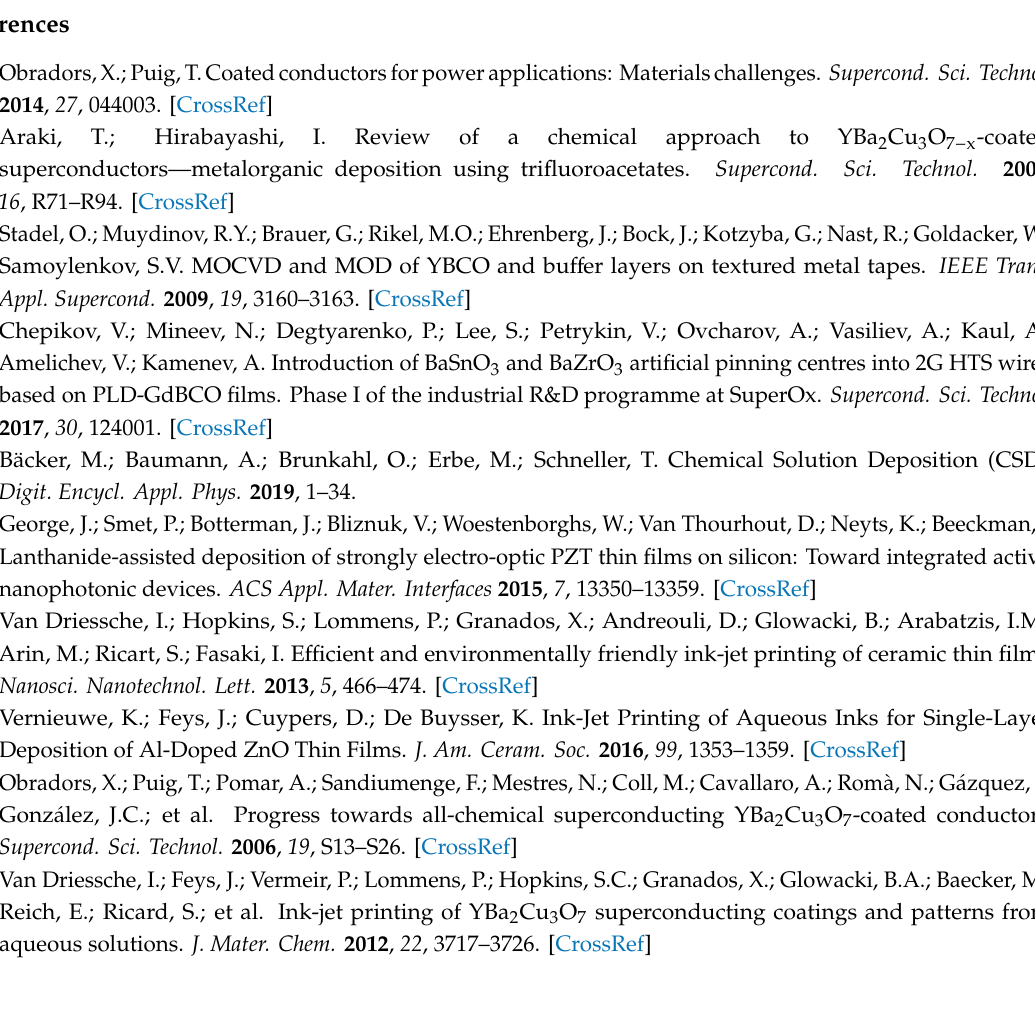
Figure S1. XRD patterns showing only reflections of the monoclinic phase after the heating-up synthesis of HfO 2 nanocrystals. Figure S2. Optimized jetting and non-jetting waveforms used for printing (A) pristine and (B) HfO 2 -YBCO inks. Figure S3. Cross-sectional SEM image of one single deposition of YBCO (A) without and (B) with 5 mol% HfO 2 nanocrystals after full thermal process. Figure S4. (A) Cross-sectional SEM view and corresponding XRD spectrum (B) of YBCO layer obtained via five deposition layers. Figure S5. Composition and microstructure after full thermal processing of an ink-jet-printed YBCO film with four deposition runs. Figure S6. Fast Fourier transform pattern of isolated BaHfO 3 particles in YBCO matrix. Figure S7. ( h 00) bright-field TEM showing the twin boundaries of (A) pristine and (B) HfO 2 -YBCO